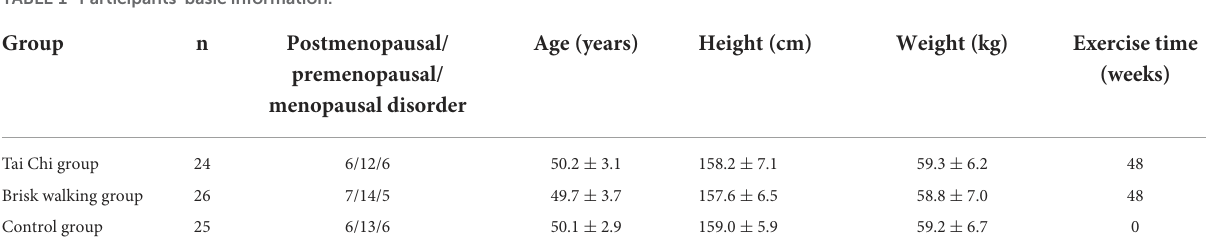
TABLE 1 Participants’ basic